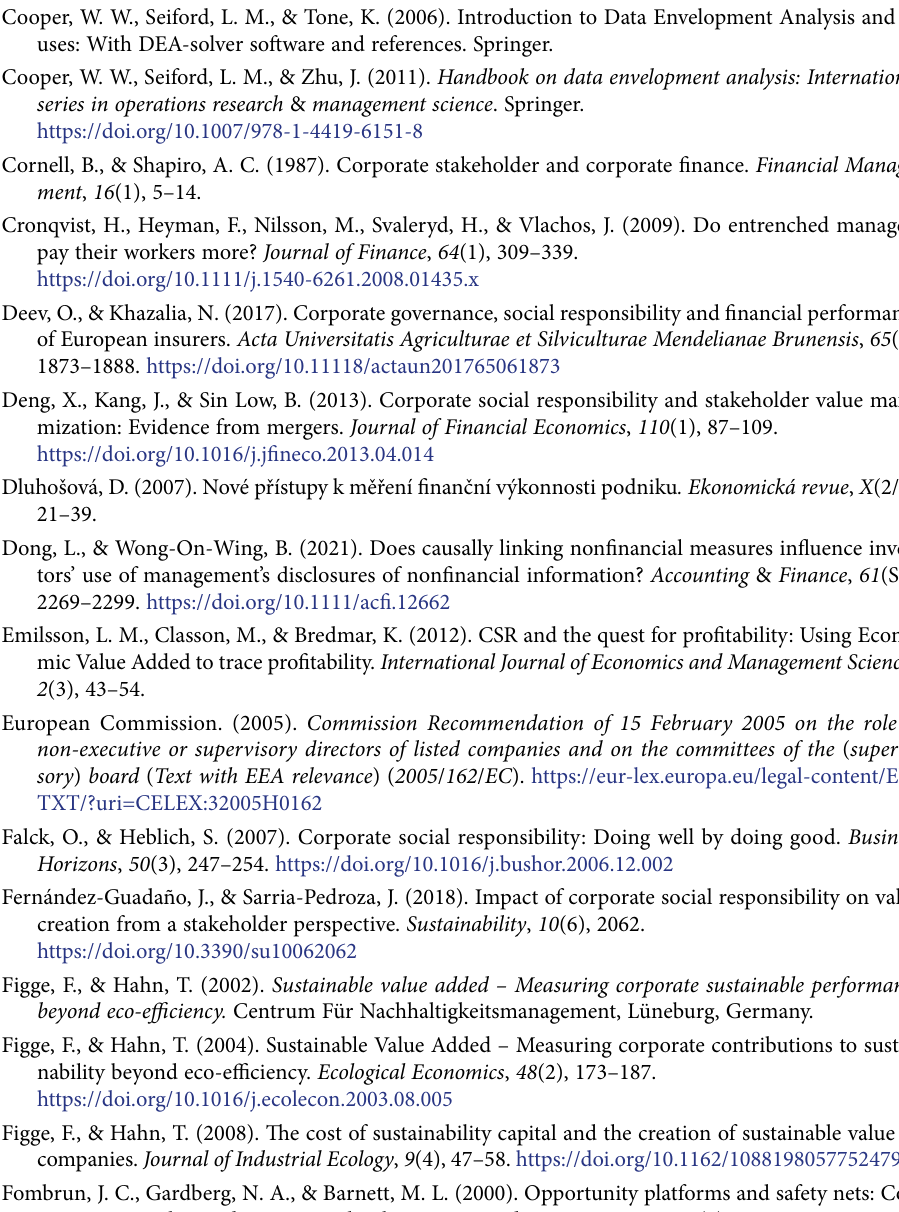
Figge, F., & Hahn, T. (2002). Sustainable value added – Measuring corporate sustainable performance beyond eco-efficiency. Centrum Für Nachhaltigkeitsmanagement, Lüneburg, Germany. Figge, F., & Hahn, T. (2004). Sustainable Value Added – Measuring corporate contributions to sustai- nability beyond eco-efficiency. Ecological Economics , 48 (2), 173–187. Figge, F., & Hahn, T. (2008). The cost of sustainability capital and the creation of sustainable value